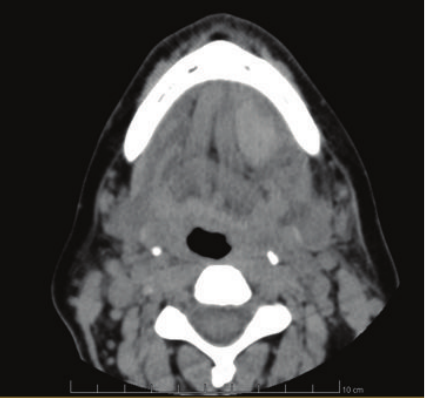
Figure 4: Clinical photograph 1 week later with good clinical recovery.